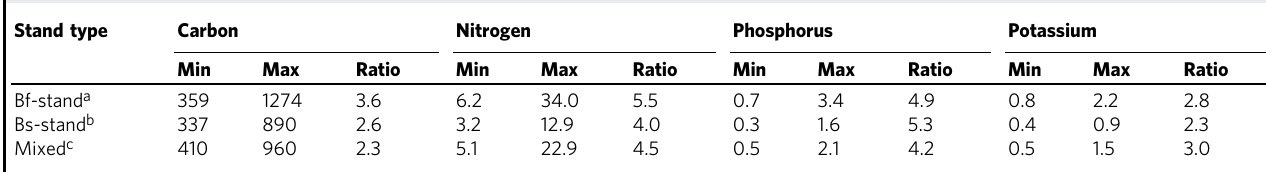
Table 1 Extent of yearly values for litterfall (needles, leaves, and spruce budworm frass) carbon and nutrients fl uxes (kg ha − 1 yr − 1 ) during a spruce budworm outbreak in northeastern Canada.